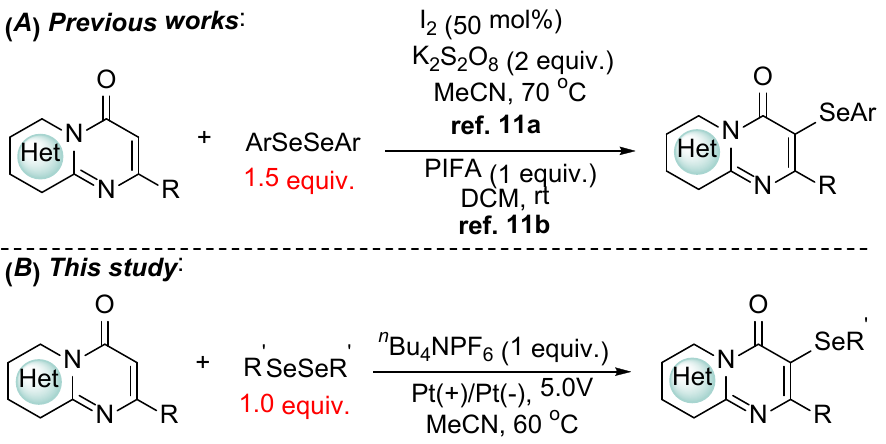
Figure 1. Representative biological